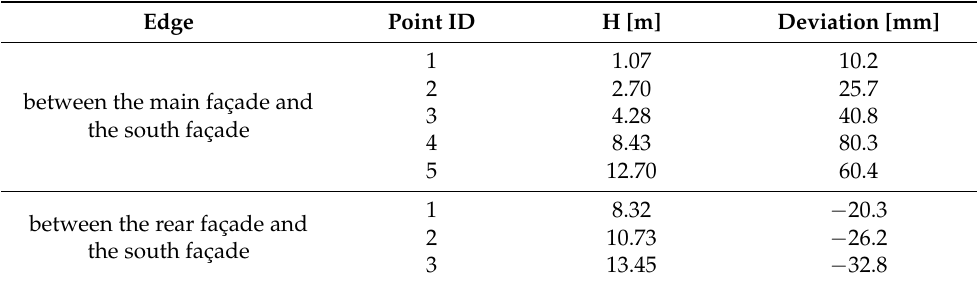
Table 1. Deviations from the vertical line of edges between the façades and the south façade—pos- itive values indicate north − south displacements.